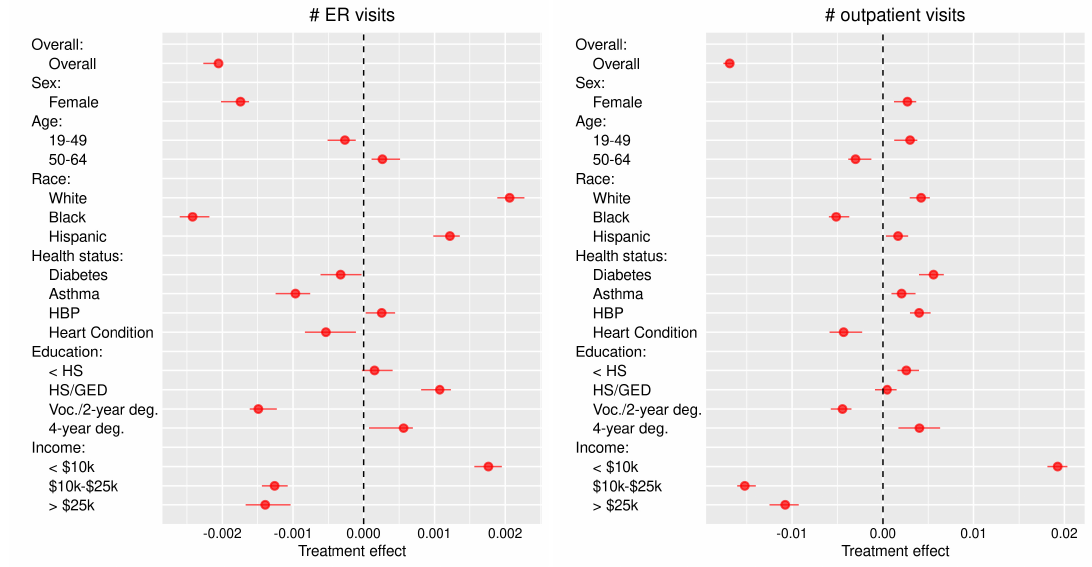
Figure 5: Heterogeneity in PATT-C treatment effect estimates. Notes: Horizontal lines represent 95% percentile bootstrap confidence